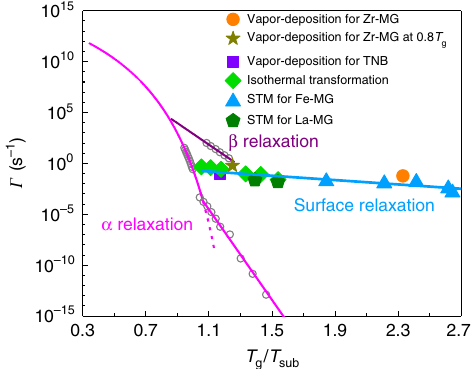
Fig. 4 Comparison of surface relaxation with bulk α and β relaxations. The magenta and purple curves along with the open circles show the bulk α and β relaxation rates vs. T T in MGs 35 , respectively. The solid square, star, g / and circle show the surface relaxation rate Γ surface vs. T g / T sub estimated from vapor deposition of an ultrastable molecular glass 5 , the Zr-MG of ref. 10 , and the sample studied in the present work, respectively. The rhombuses are for ethylcyclohexane glass as Γ surface is the inverse critical free surface residence time at which the time of isothermal transformation from the glass into the supercooled liquid state reaches the plateau (Figure 9 in ref. 21 ). The Γ surface from STM measurements are plotted as pentagons (left one: La 50 Ni 15 Al 25 Cu 10 , right one: La 60 Ni 15 Al 25 MGs 32 ) and as triangles